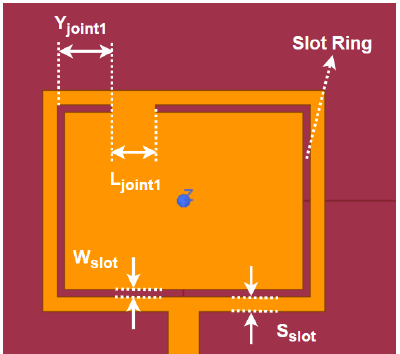
Figure 1. Adding the first joint part on the top of the ring slot.